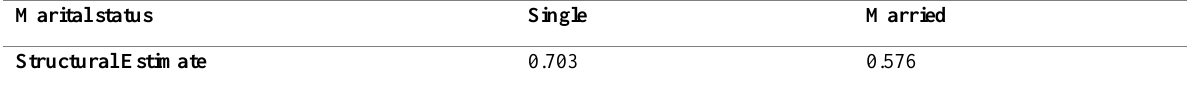
Table 3: Relationship among number of alternatives and post-purchase regret on marital status Marital status Single Structural Estimate